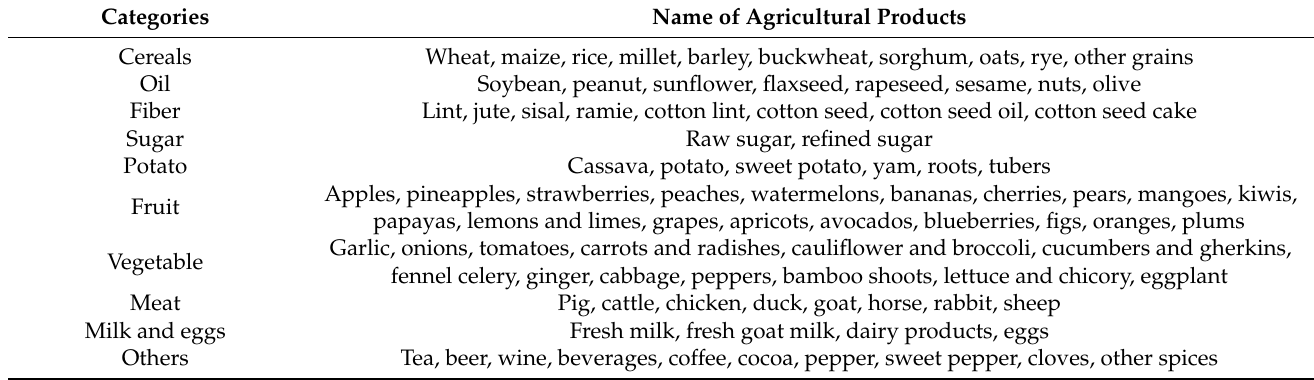
Table 1. Ten global agricultural trade categories covered in this